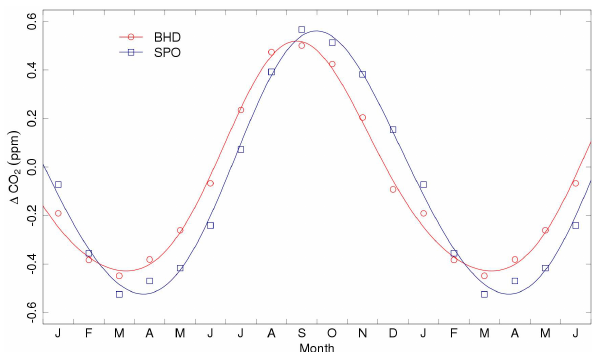
Fig. 5. Long-term average Baring Head and South Pole seasonal CO 2 cycles shown as monthly means of the STL fit seasonal com- ponent (symbols) along with 2-harmonic fits to detrended monthly mean data (lines). 18 months are shown with Jan–Jun repeated for